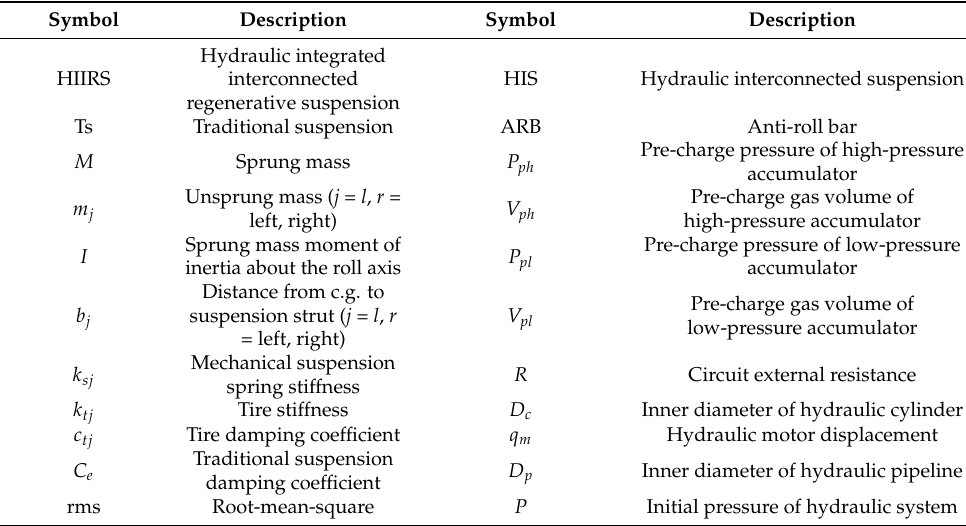
Table A1. Descriptions for symbols in